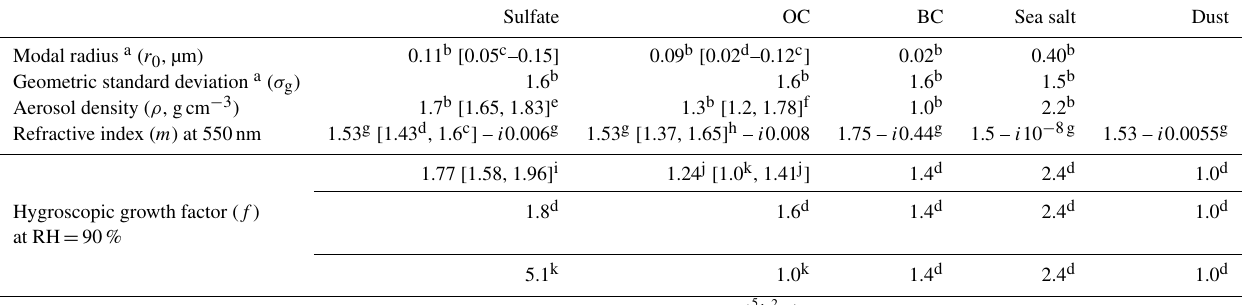
Table 1. Optical properties used to calculate AOD CMAQ in FlexAOD. Values in square brackets represent the range of uncertainties for each parameter, which we used in FlexAOD sensitivity tests to quantify their impacts on the satellite-derived PM 2 . 5 . Sulfate OC BC Sea salt Dust Modal radius a ( r 0 ,